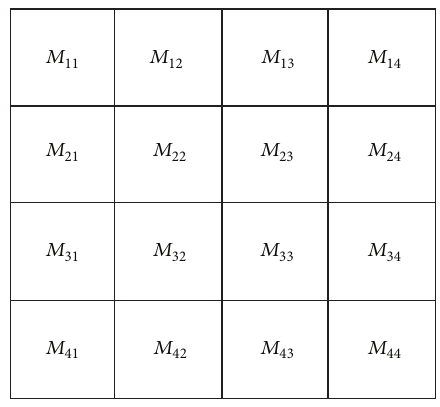
Figure 1: Layout of image